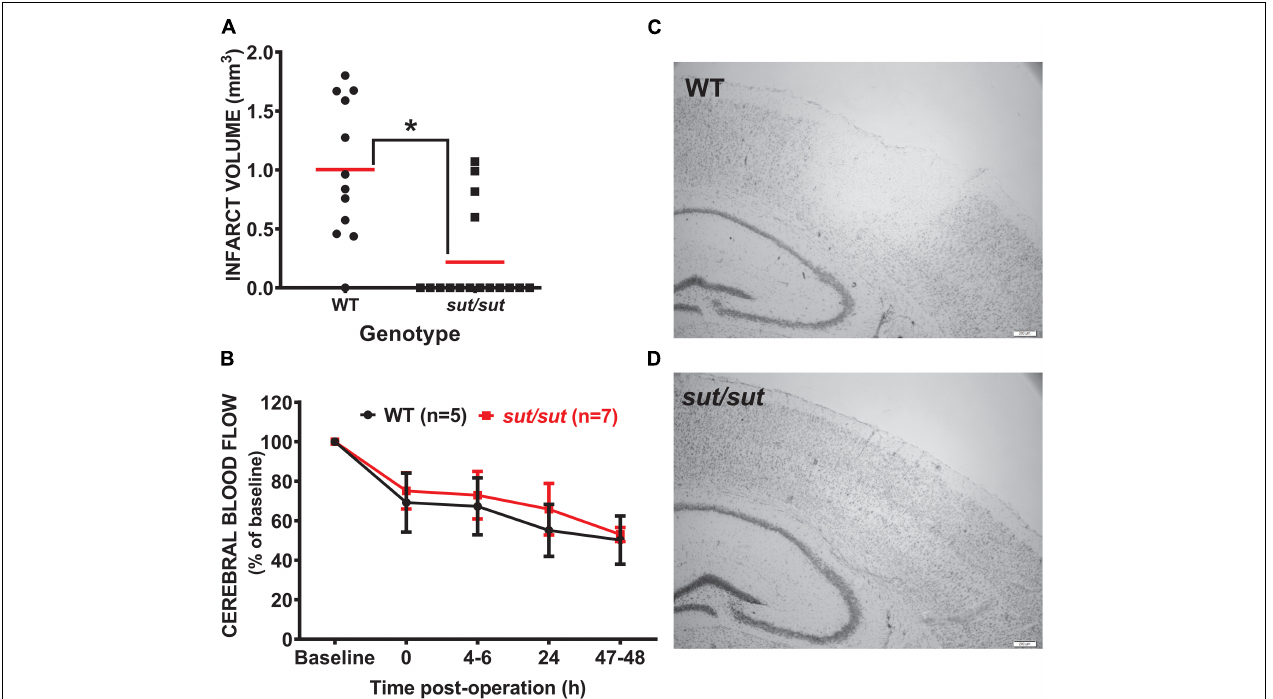
FIGURE 1 | Comparison of infarct incidence and size between WT and Sx c − null mice following photothrombotic-induced ischemia. (A) Forty-eight h after PTI, brains of sut/sut ( n = 16) mice and their WT ( n = 13) littermates were removed. Coronal sections (20 µ m) were cut along the rostral-caudal axis ( − 2.0 to − 3.6 relative to bregma) and stained with thionin, with areas lacking thionin staining represent ischemic damage. Infarct volume was determined as described in Methods. Each data point (black dot: WT; black square: sut/sut) represents total infarct volume in mm 3 from an individual mouse, whereas the horizontal red line represents the mean (B) Depicts rCBF as determined via laser speckle contrast imaging represented as mean fold change ± SD from baseline (set to 100) taken immediately prior to illumination and at intervals following illumination as described in methods. (C) Representative thionin staining of brain tissue of Slc7a11 + / + (WT) and (D) Slc7a11 sut / sut (sut/sut) mice. A significant difference in infarct volume (* p = 0.0007) was determined by two-tailed Mann Whitney U -test. Infarct incidence − defined as the number of mice with any size infarct divided by the total number of mice—also differed significantly between genotypes as assessed